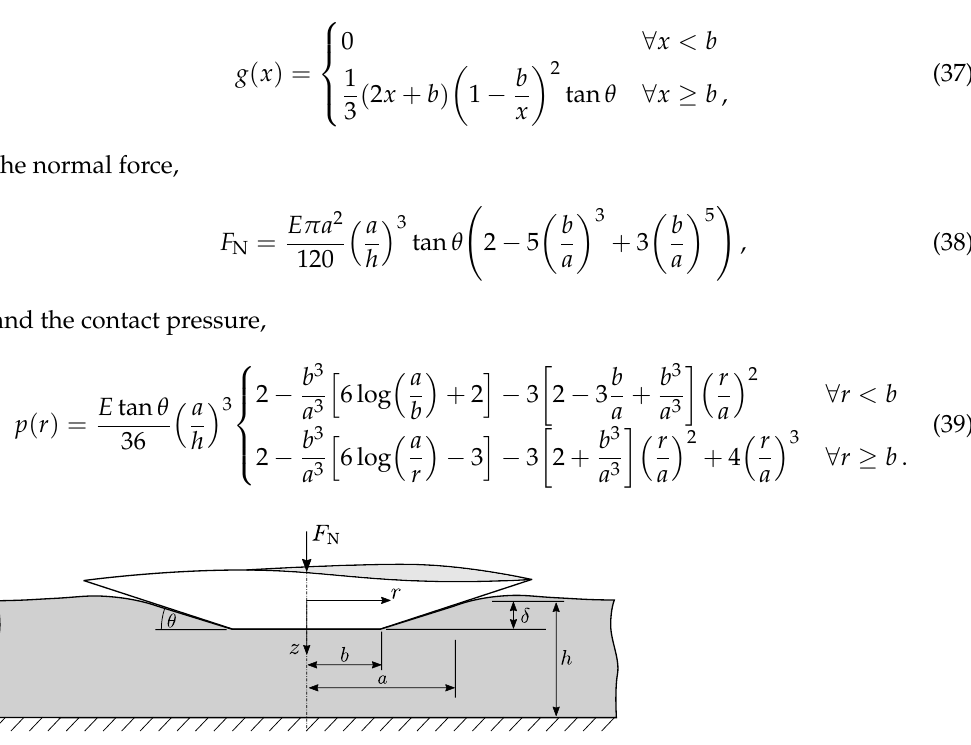
Figure 6. Indentation of a layer by a truncated